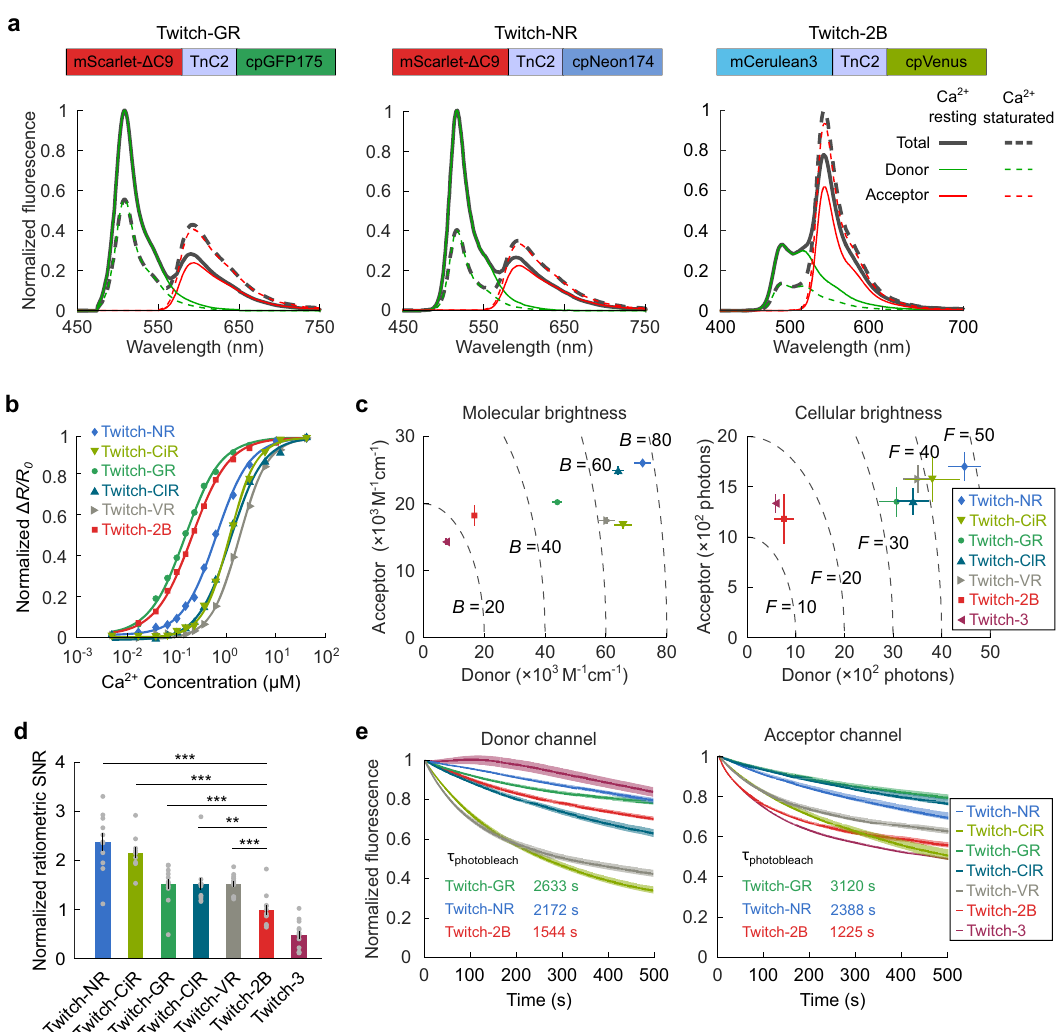
Fig. 2 A palette of optimized green-red fl uorescent GECIs displayed high Ca 2 + sensitivity, brightness, and photostability. a Average spectra of Twitch- GR, Twitch-NR, and Twitch-2B in Ca 2 + -resting and Ca 2 + -saturated states ( n ≥ 10 cells). b Ca 2 + titration curves for Twitch-GR, Twitch-NR, Twitch-CiR, Twitch-ClR, Twitch-VR, and Twitch-2B. Solid lines are linear regressions of the data to a fi rst-order Hill model. c The molecular ( left ) and cellular ( right ) brightness of various sensor candidates calculated from spectral measurements and dual-view images, respectively (error bars are s.e.m., n ≥ 10 cells for each sensor in the molecular brightness test and n ≥ 100 cells for each sensor in the cellular brightness test). Dashed lines denote isocontours of equal total molecular brightness or total cellular brightness. d The ratiometric SNR of various green-red sensor candidates when changing from the Ca 2 + -resting state to the Ca 2 + -saturated states were signi fi cantly higher than the ratiometric SNR of Twitch-2B (error bars are s.e.m.; ** signi fi es p < 0.01, *** signi fi es p < 0.001, two-sided Wilcoxon rank-sum test; n ≥ 10 cells for each sensor). The SNRs were normalized to the average SNR of Twitch-2B. Gray dots indicate individual data points. e Average photobleaching curves of various sensor candidates expressed in HEK293 cells in the resting state, separated into donor ( left ) and acceptor ( right ) fl uorescence channels (shaded regions are s.e.m, n ≥ 30 cells for each sensor). The illumination intensity was 5 mW/mm 2